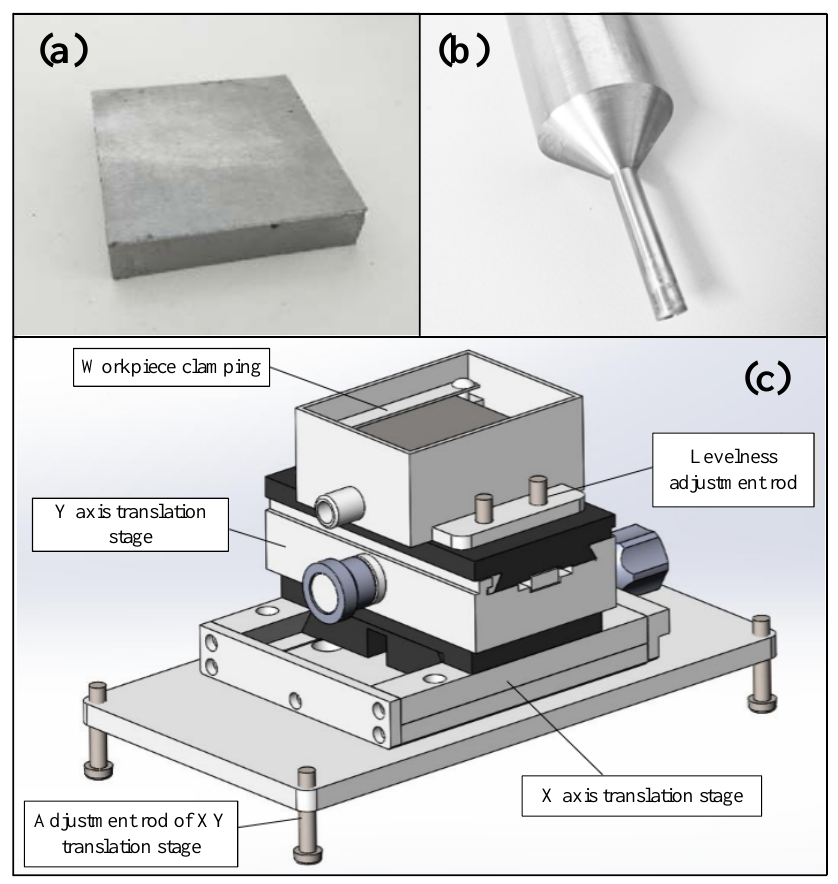
Figure 2. ( a ) Workpiece block; ( b ) Tool electrode; ( c ) Workpiece installation